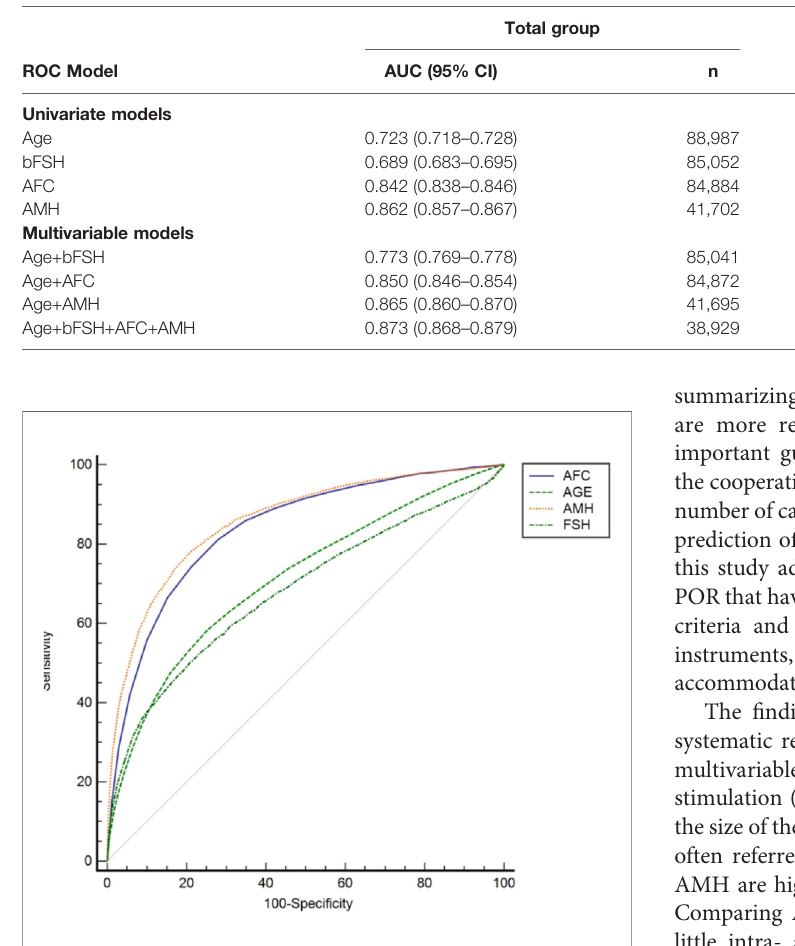
FIGURE 2 | ROC curves of the POR prediction model by each